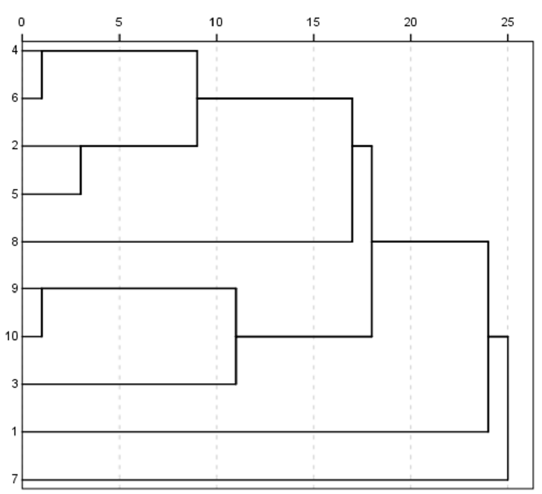
Figure 6. Cluster analysis of volatile compounds in Qu Aurantii Fructus and Aurantii Fructus. Note: X axis represents the classification distance, Y axis represents samples (1: Citrus aurantium L.; 2: Cit-